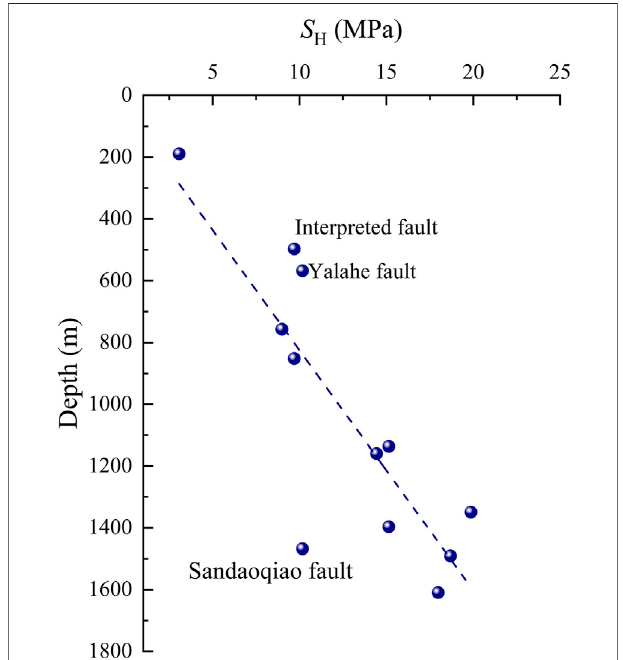
FIGURE 10 | Maximum horizontal principal stress and depth in the intersection area of fault and the tunnel